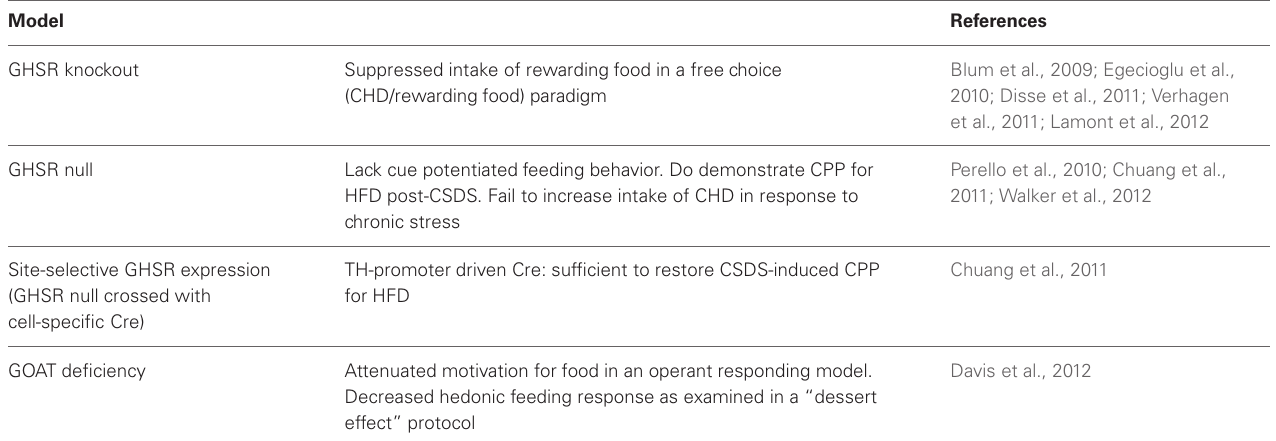
Table 2 | Studies of hedonic eating behaviors in mouse models with genetic alterations in ghrelin-signaling system.